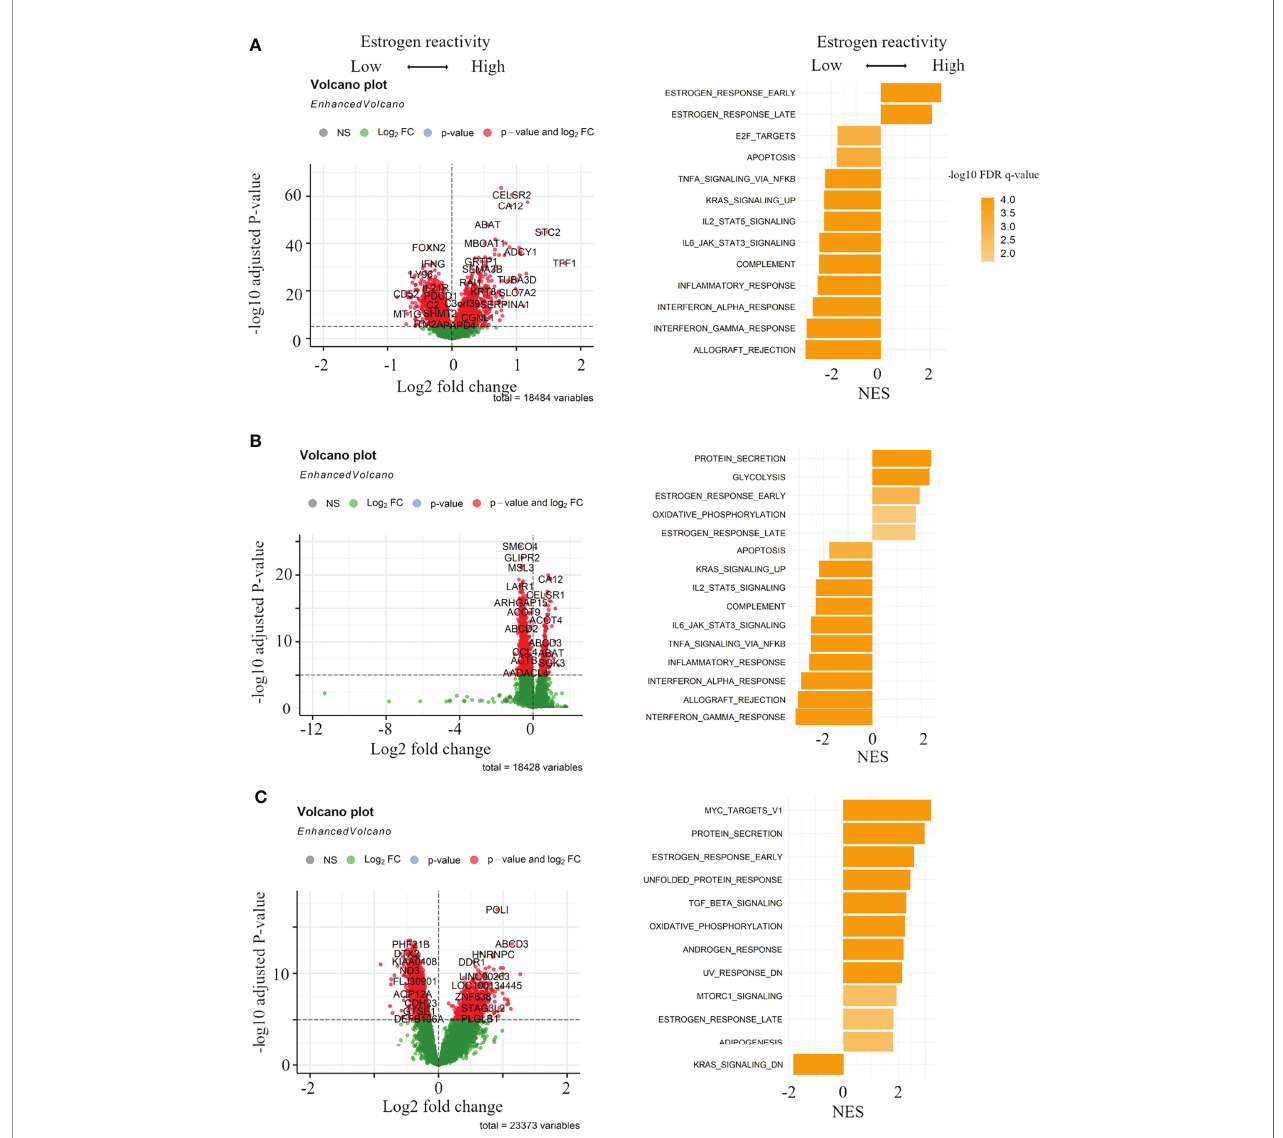
FIGURE 2 | Gene expression pro fi les in the levels of estrogen reactivity. Volcano plots illustrating the differentially expressed mRNAs of BC and pre-ranked GSEA of BC patients comparing high vs. low estrogen reactivity in METABRIC cohort (A) and TCGA BC cohort (B) and our institutional cohort (C) . Left panels: In volcano plots, X-axes: log2 FC; Y-axes: -log 10 P-value from limma analysis. mRNAs with P-value < 0.05 in red, all others in green. Right panels: in pre-ranked GSEA, orange bar shows NES and its shading shows the – log10 FDR q-value. We only considered gene sets signi fi cantly enriched that met a threshold of NES >1.8 or <-1.8 and FDR q-value < 0.01. BC, breast cancer; GSEA, Gene Set Enrichment Analyses; METABRIC, Molecular Taxonomy of Breast Cancer International Consortium; TCGA, The Cancer Genome Atlas; FC, fold change; NES, normalized enrichment score; FDR, false discovery rate; HR, hormone